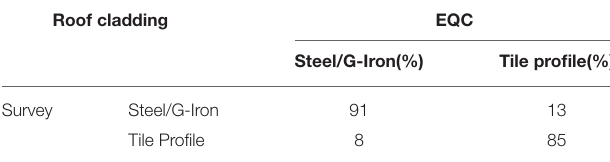
TABLE 10 | Comparison of roof cladding between EQC portfolio and survey data. Roof